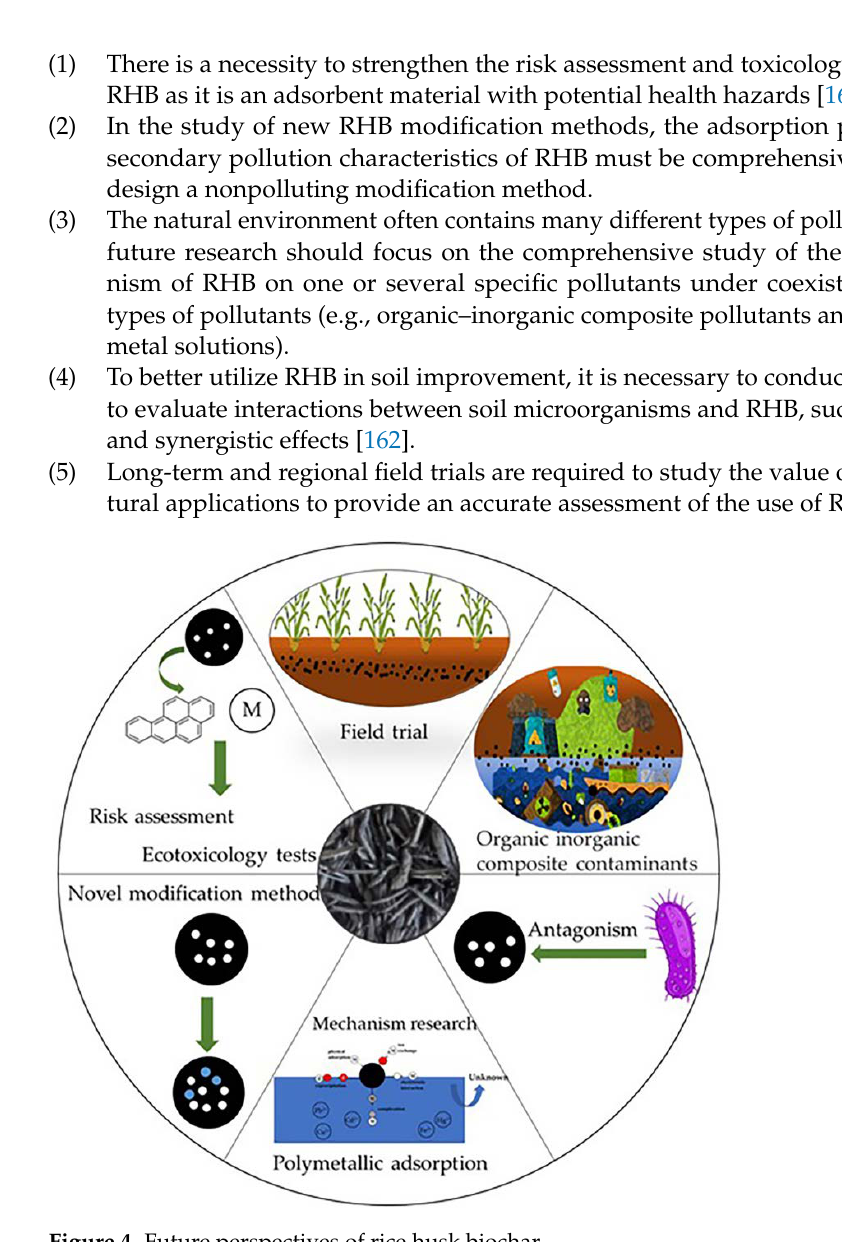
Figure 4. Future perspectives of rice husk biochar.